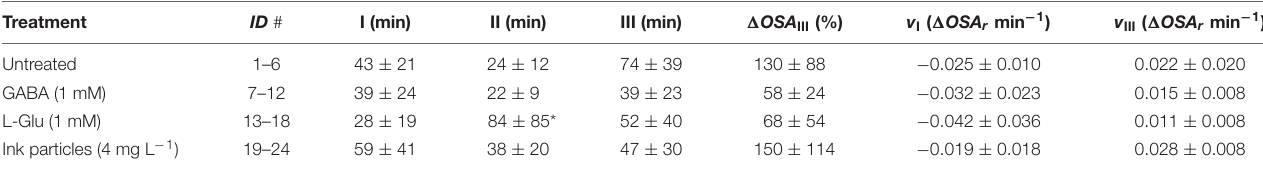
TABLE 2 | Halichondria panicea . Spontaneous (i.e. untreated conditions) and induced (by exposure to the neurotransmitters GABA, L-Glu or ink particles) contraction-expansion events of sponge explants ( n = 6, ID #1–24), expressed by changes in the relative osculum cross-sectional area ( OSA r ). Treatment